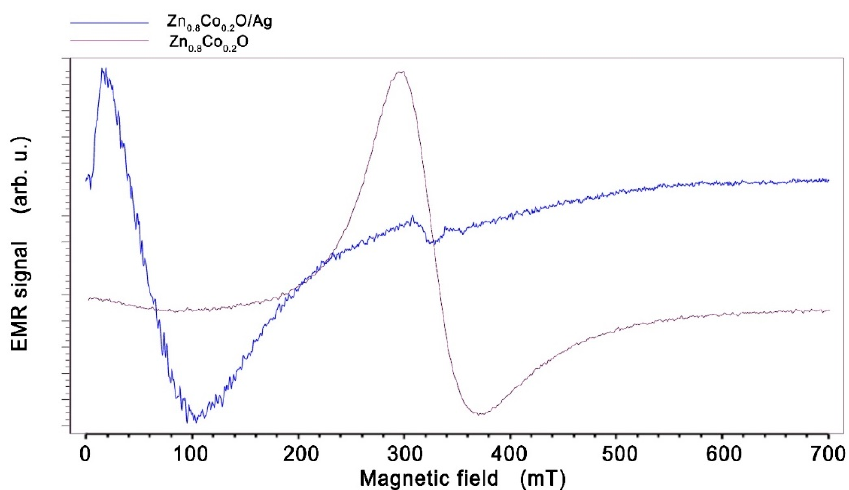
Figure 3. EMR spectra of Zn 0.8 Co 0.2 O (purple) and Zn 0.8 Co 0.2 O embedded with Ag NPs (blue), obtained at temperature 160